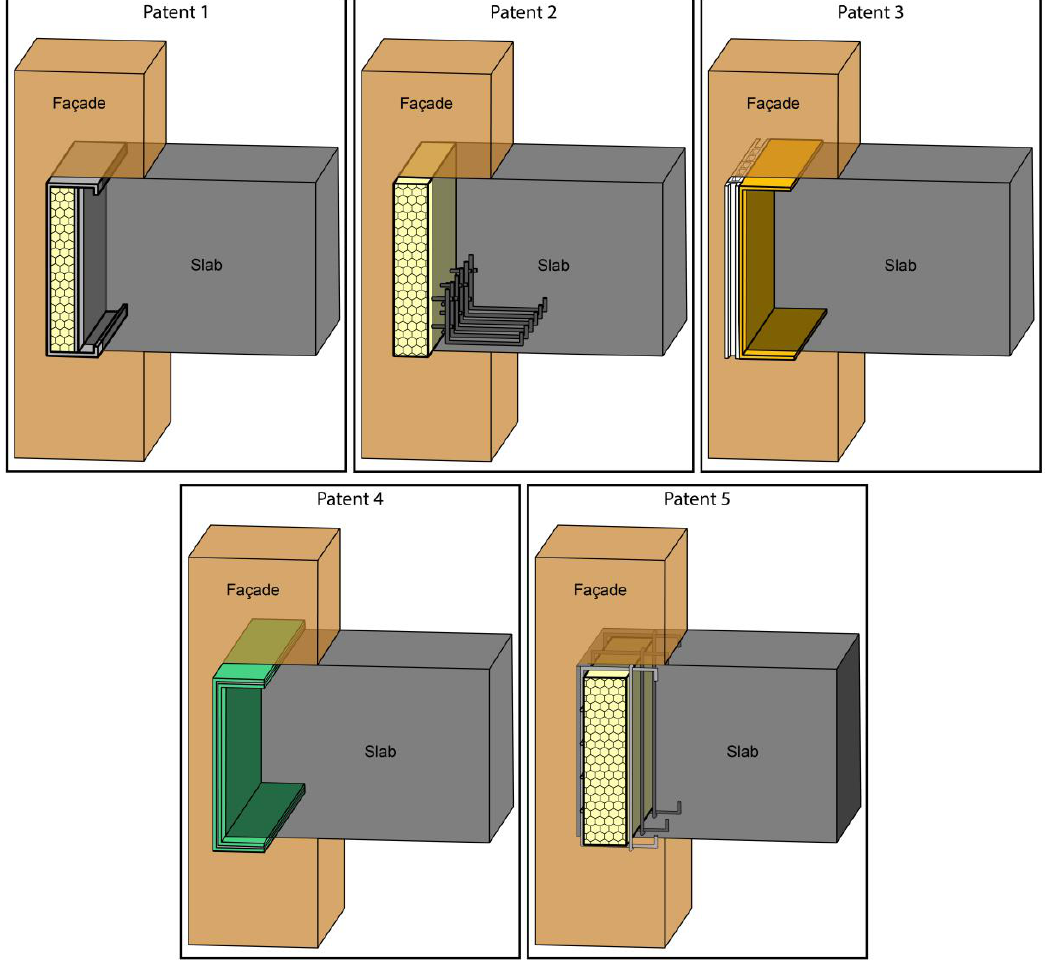
Figure 1. Detail of the patents analysed.